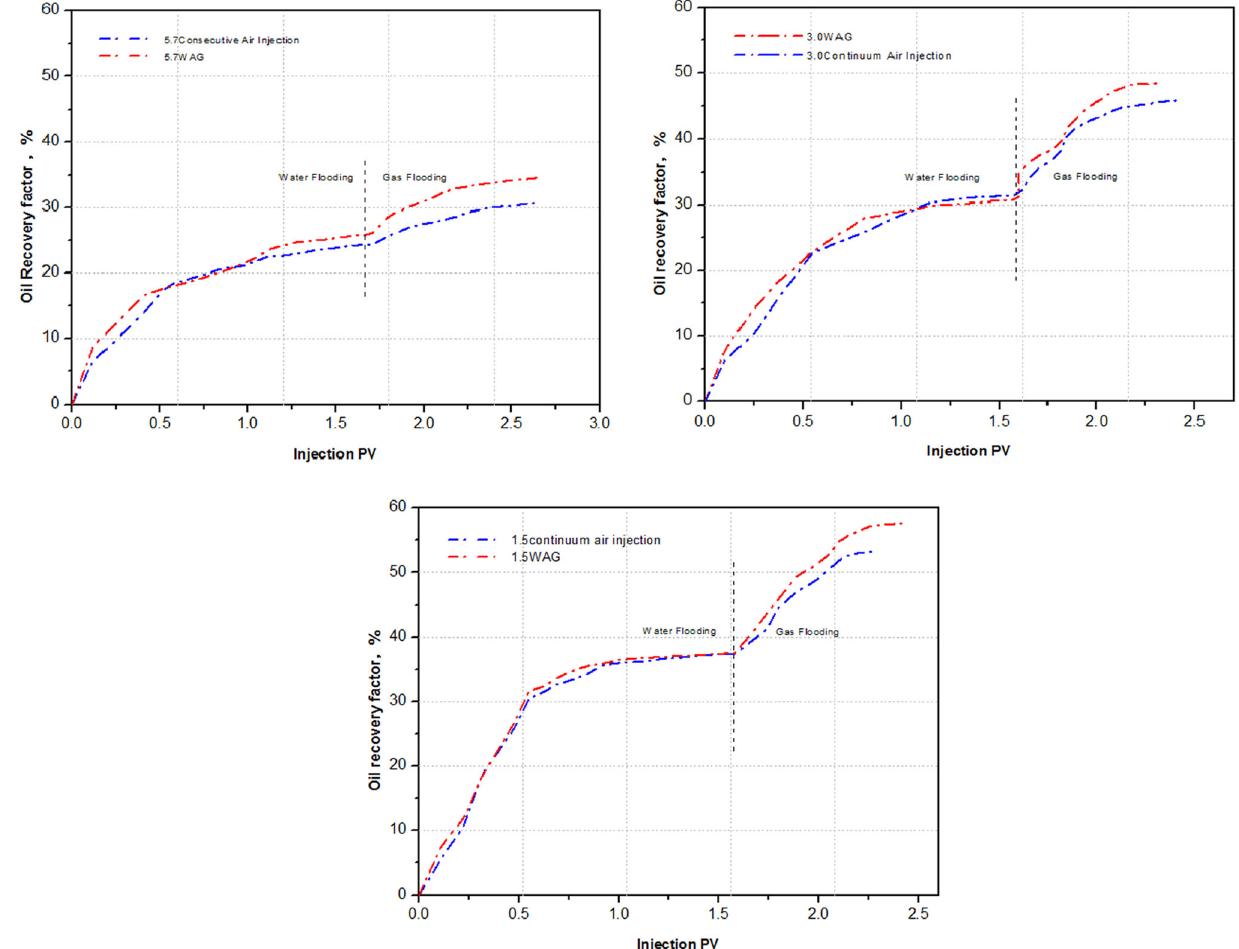
Fig. 10 Oil Recovery factor for different injecting mode with same permeability contrast, left for 5.7, middle for 3.0 and right for